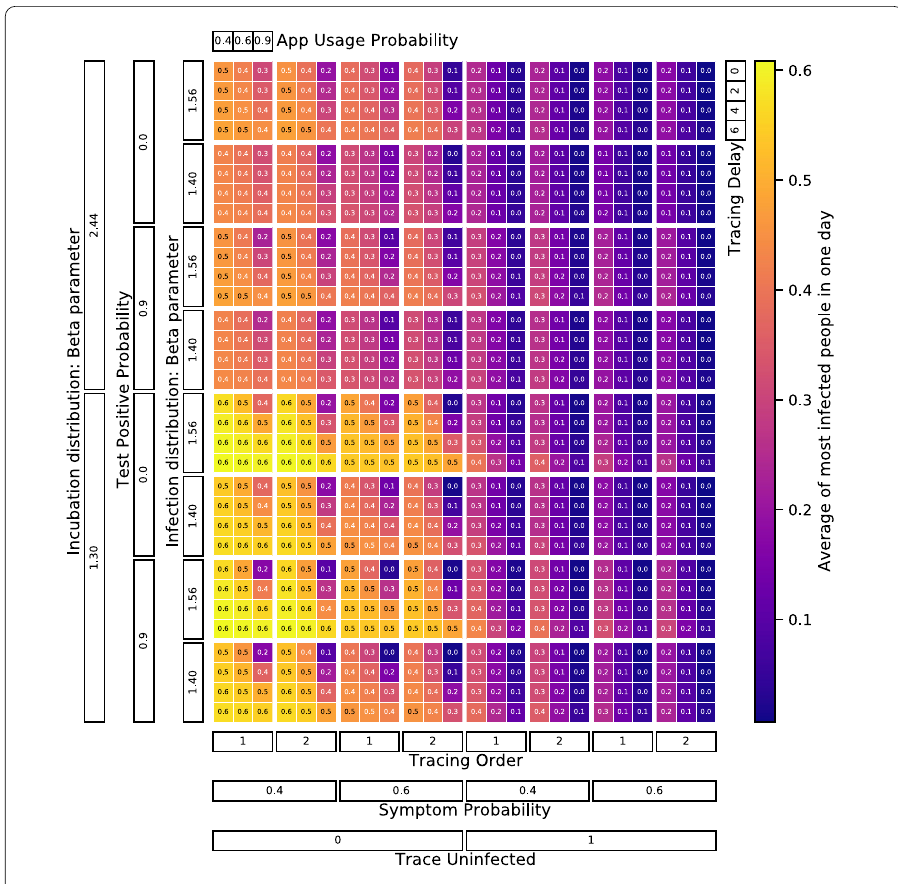
Figure 33 The fraction of the population that is sick on the day when most people are sick is shown for all combinations of parameter in the timing and delay parameter